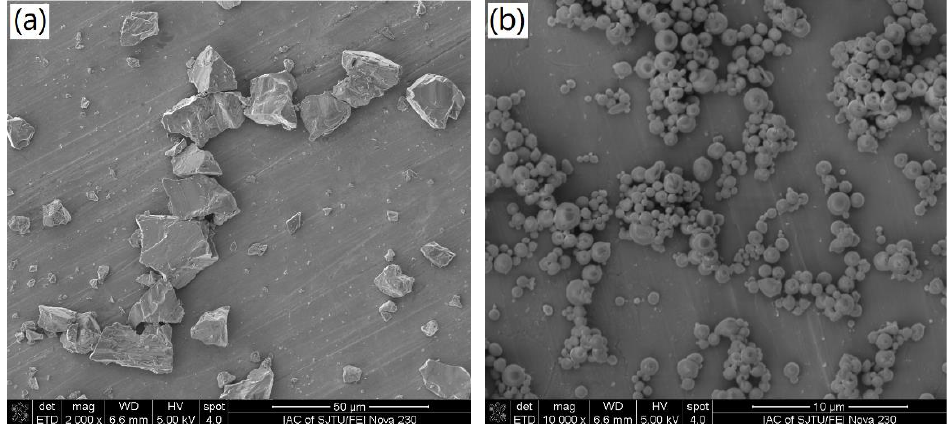
Figure 1. SEM micrographs of ( a ) TiH 2 and ( b ) Al particles.